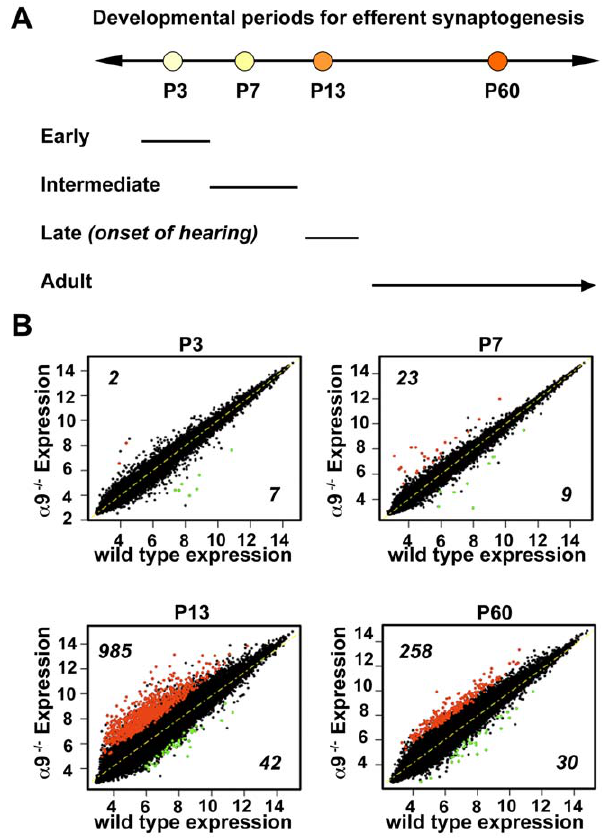
Figure 1. Overview of differentially expressed genes in the a 9 2 / 2 compared to wild type. ( A ) The ages indicate the postnatal (P) days at which cochlear RNA samples were prepared. Efferent innervation in the cochlea peaks around P7 when most of the efferent axons are contacting inner hair cells. Between P7 and P13, the axons are pruned and retargeted to outer hair cells. P13 also marks the initial phase of auditory function stabilization in rodents. Microarray analyses were based on comparative analyses of a 9 2 / 2 and wild type at P3, P7, P13 and P60. ( B ) Comparison of expression levels of all probes between a 9 2 / 2 samples and wild type controls at each age. Normalized gene expression data are plotted on a logarithmic scale (log 2 ), and genes changing in the a 9 2 / 2 by at least 1.5 fold and differentially expressed using the limma package in R (FDR q-value , 5%) are highlighted for each age. Red dots correspond to significant up-regulation and green to significant down-regulation in the knockout animals compared to wild type controls. Numbers of up- and down-regulated genes are also noted in the plots. used DAVID (Database for Annotation, Visualization and